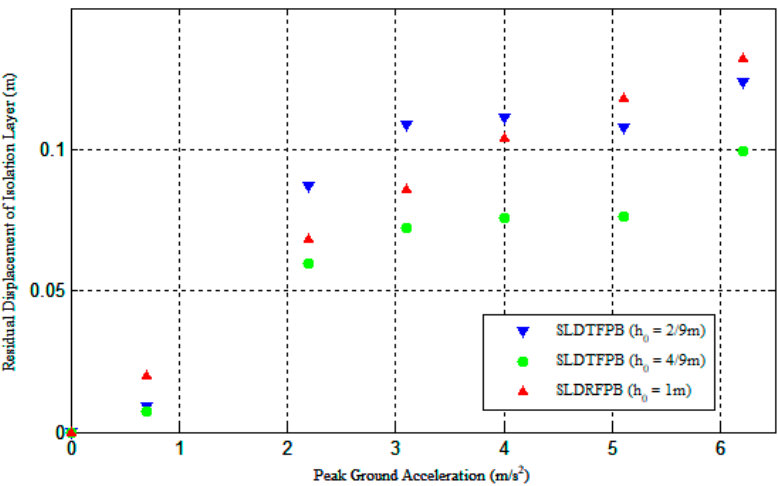
Figure 18. Residual displacements of isolation layers equipped with SLDTFPB or SLDRFPB.